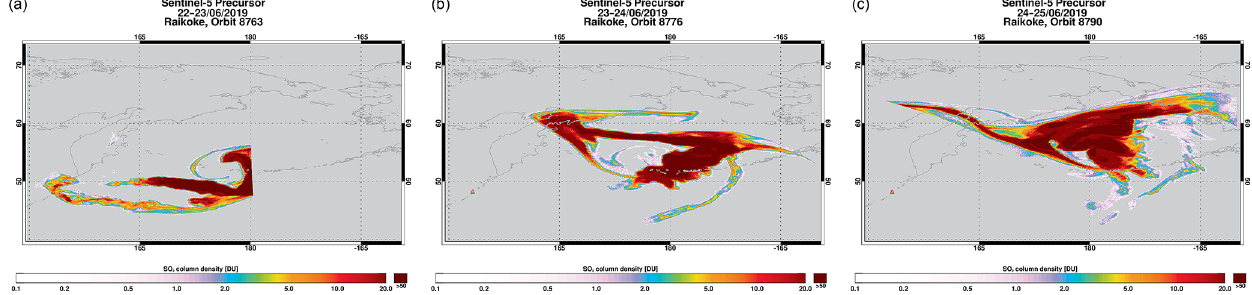
Figure 13. SO 2 VCD for the TROPOMI measurements of the Raikoke volcanic eruption, measured on 22/23 June 2019 (a) , 23/24 June 2019 (b) , and 24/25 June 2019 (c) , with overpass times of around 02:00 UTC (Orbit 8763, a ), and 00:00UTC (orbits 8776 and 8790).